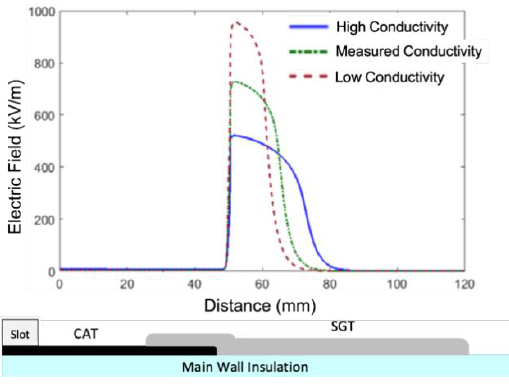
Figure 53. Electric field distribution along the stress-grading system of an inverter-fed rotating machine. © 2021 IEEE. Reprinted, with permission, from [40].